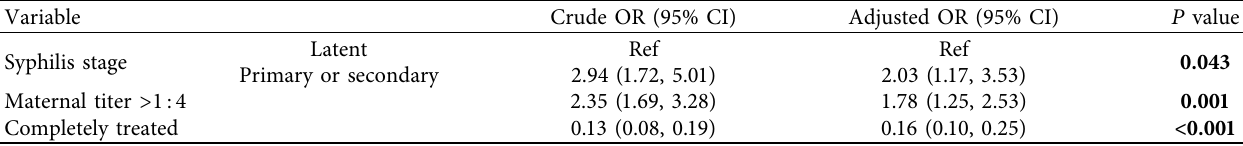
Table 2: Multiple logistic regression analysis on associations between gestational syphilis and